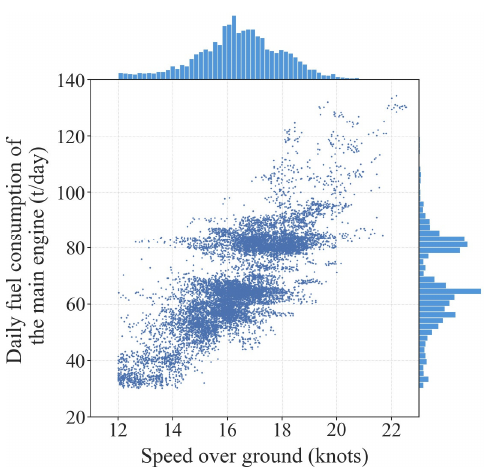
Figure 1. Distribution of SOG and daily fuel consumption of the main